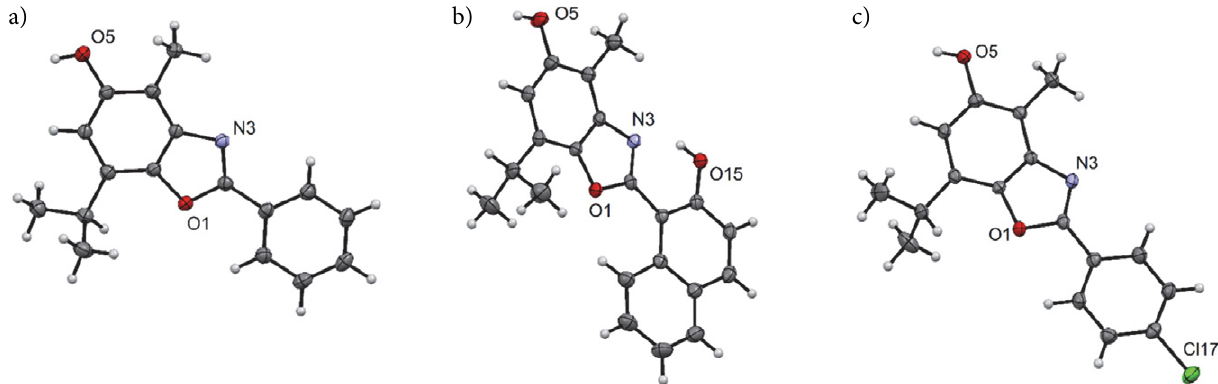
Figure 2 . Crystal structures of compounds 1 (a), 16 2 (b), and 3 (c) with heteroatom labelling. Thermal ellipsoids are drawn at 50% probability level.